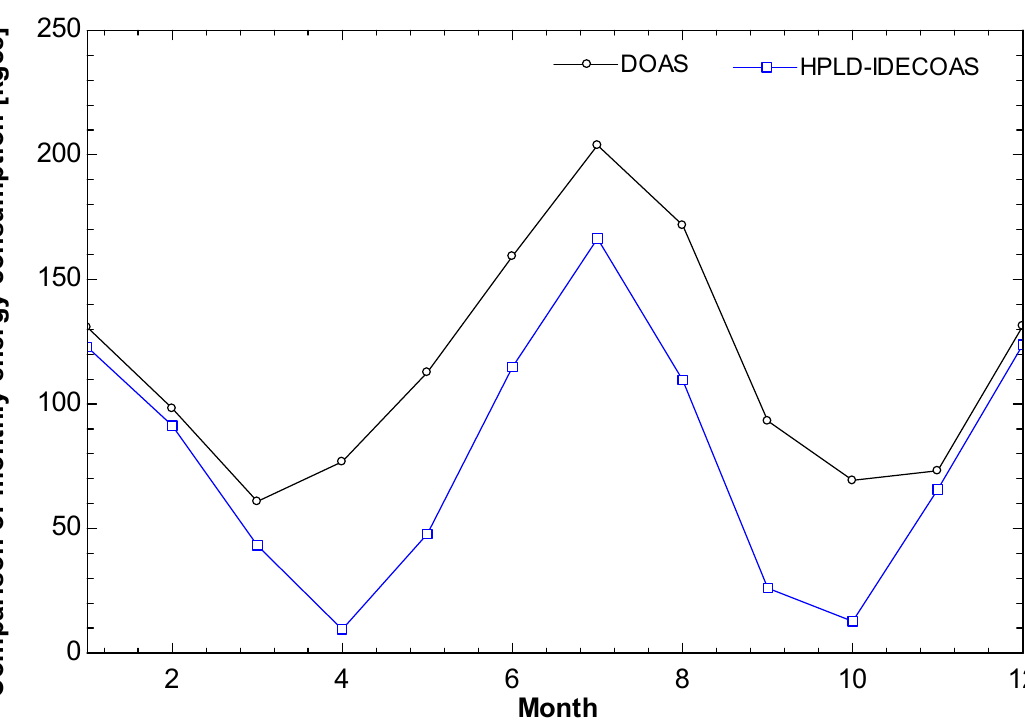
Figure 17. Comparison of monthly energy consumption in Kashi.